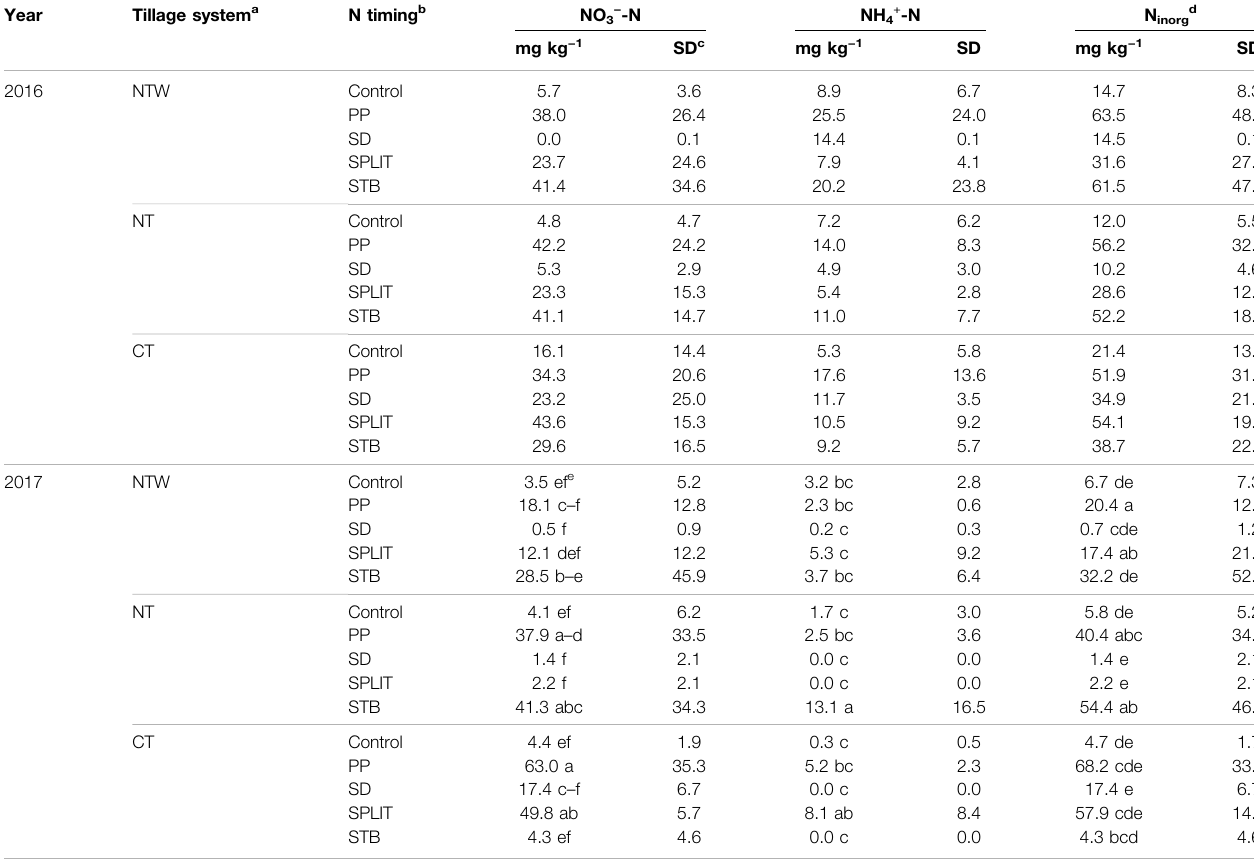
TABLE 2 | Nitrate-N (NO 3 − -N) and ammonium-N (NH 4+ -N) concentrations (0 – 15 cm depth) prior to mid-season (MS) N fertilizer application. Tillage system